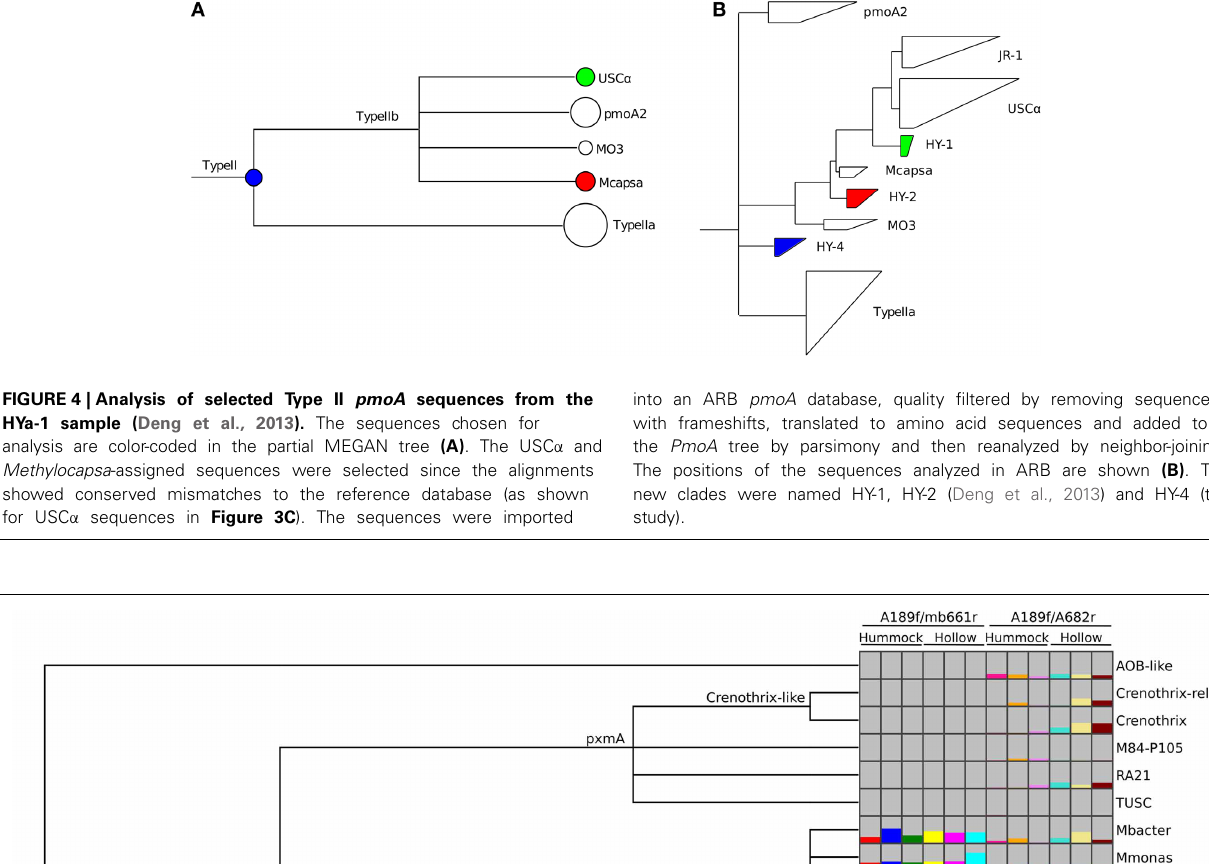
into an ARB pmoA database, quality filtered by removing sequences with frameshifts, translated to amino acid sequences and added to the PmoA tree by parsimony and then reanalyzed by neighbor-joining. The positions of the sequences analyzed in ARB are shown (B) . The new clades were named HY-1, HY-2 (Deng et al., 2013) and HY-4 (this study).